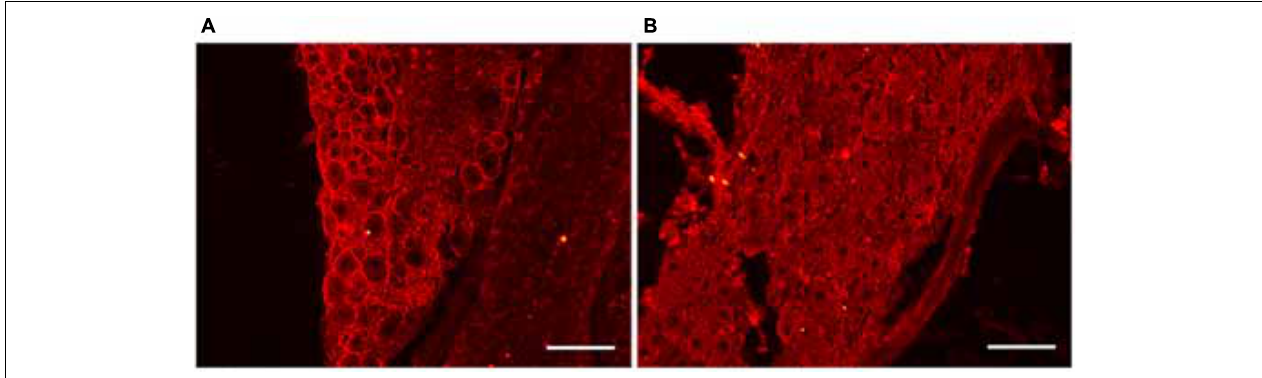
FIGURE 7 | M β CD disruption of lipid rafts in DRG neurons. (A,B) Representative images of the DRGs of animals treated with vehicle (A) and M β CD (B) . Note the absence of CTxB membrane staining in B after M β CD treatment, indicating lipid raft disruption. Scale bar: 100 µ